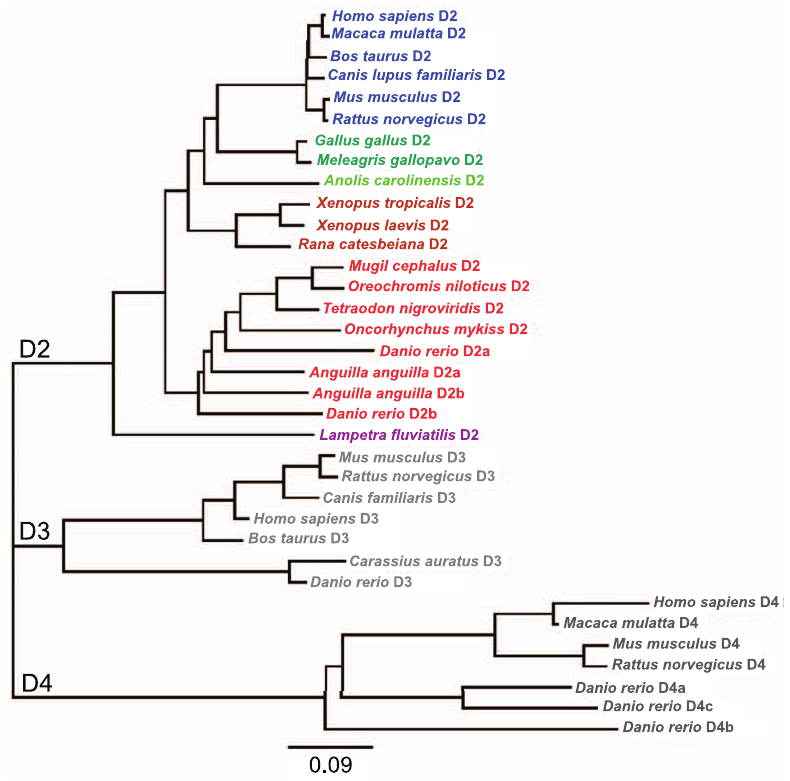
Figure 3. Phylogenetic analysis of vertebrate dopamine receptors of the D2-family. The distant tree was built with the neighbor-joining algorithm from alignments of the D2, D3 and D4 receptor subtypes from several vertebrate species. Data were re-sampled by 1000 bootstrap replicates to determine confidence indices within the phylogenetic tree. The scale bar refers to a phylogenetic distance of 0.09 amino acid substitution per site. The different vertebrate classes are indicated by different colors (mammals, blue; birds, dark green; reptiles, light green; amphibians, brown; fish, red; cyclostomes, mauve). GenBank accession numbers of the sequences are: Homo sapiens D2, AAA52761; Macaca mulatta D2, XP_001085571; Bos taurus D2, DAA22356; Canis lupus familiaris D2, AAG34494; Mus musculus D2, NP_034207; Rattus norvegicus D2, NP_036679; Gallus gallus D2, NP_001106761; Meleagris gallopavo D2, AAD03818; Anoils carolinensis D2, XP_ 003217484; Xenopus tropicalis D2, XP_002937871; Xenopus laevis D2, CAA51412; Rana catesbeiana D2, BAI70438; Mugil cephalus D2, AAU87970; Oreochromis niloticus D2, AAU87971; Tetraodon nigroviridis D2, CAF97490 ; Oncorhynchus mykiss D2, CAC87873; Danio rerio D2a, AAN87174; Danio rerio D2b, AAP94011; Anguilla anguilla D2A, ABH06893; Anguilla anguilla D2B, ABH06894; Lampetra fluviatilis D2, ADO23655; Mus musculus D3, 2105315A; Rattus norvegicus D3, 1614344A; Canis lupus familiaris D3, XP_545106; Homo sapiens D3, 1705199A ; Bos taurus D3, NP_001179824; Carassius auratus D3, ABN70936; Danio rerio D3, AAN87173; Homo sapiens D4, 1709359A; Macaca mulatta D4, XP_001087197; Mus musculus D4, 2109259A; Rattus norvegicus D4, AAA18588;